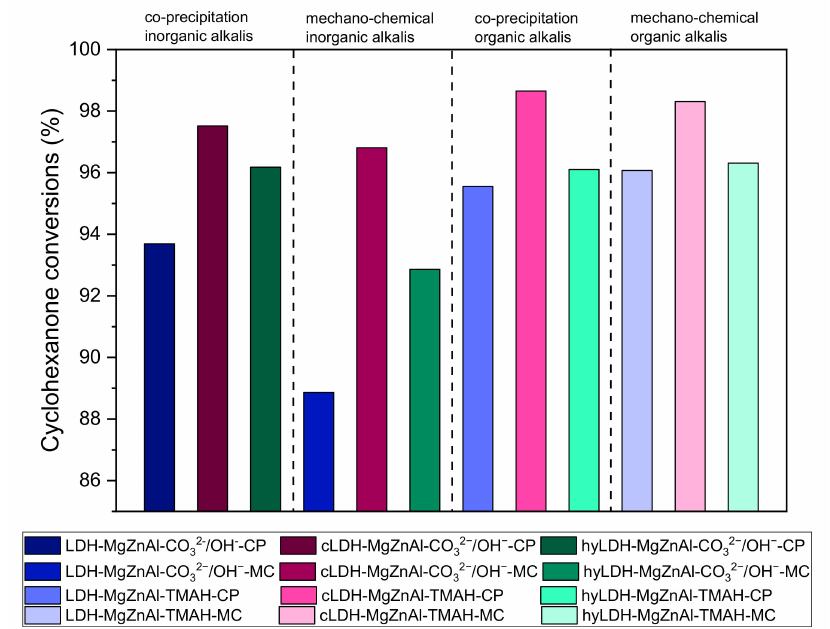
Figure 5. Cyclohexanone conversion after aldol condensation for 2 h, 120 ◦ C, 20 mg of catalyst.